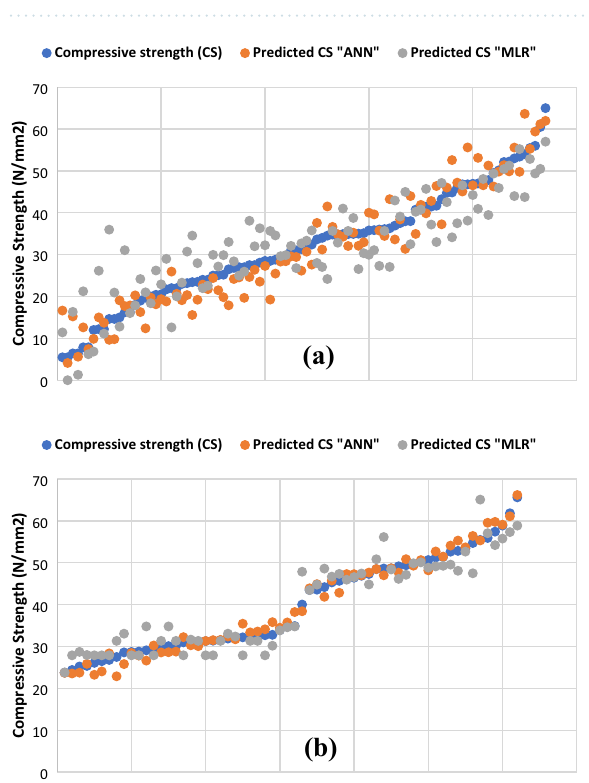
Figure 4. Regression Graphs for MLR models. ( a ) Model 1. ( b ) Model 2.